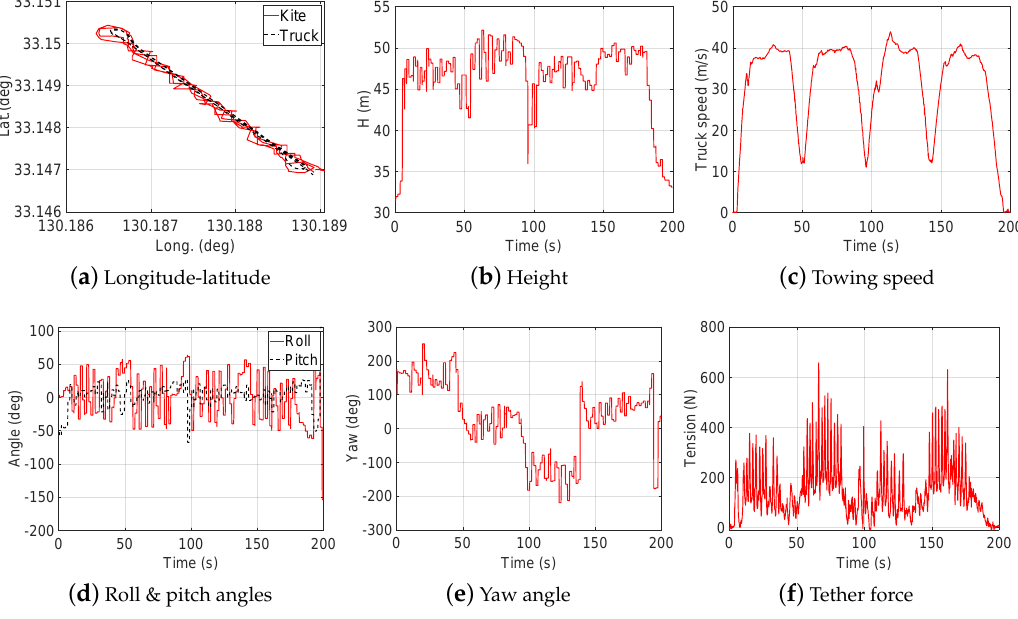
Figure 12. Data for test